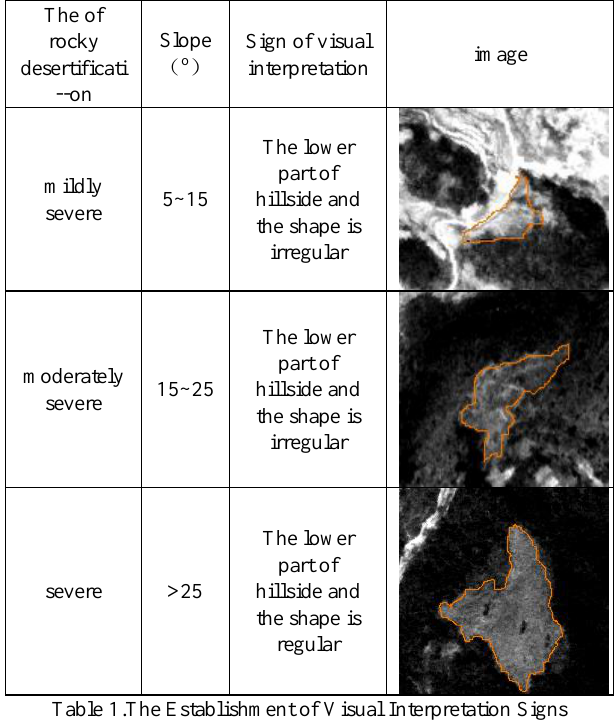
Table 1.The Establishment of Visual Interpretation Signs